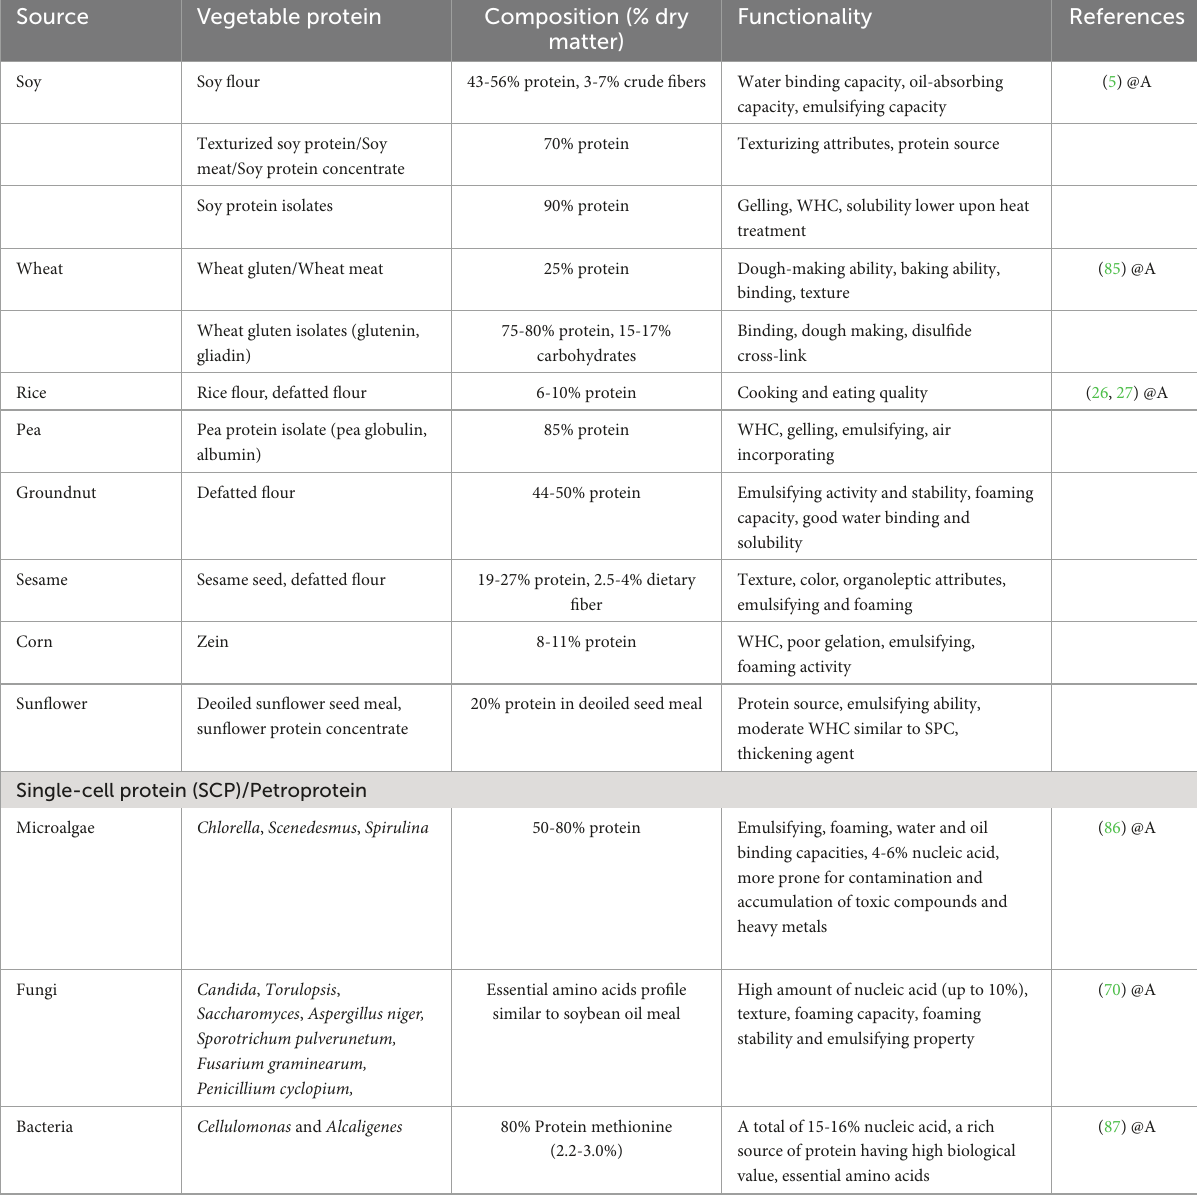
TABLE 1 Characteristics of major proteins used in the preparation of meat analogs. Source Vegetable